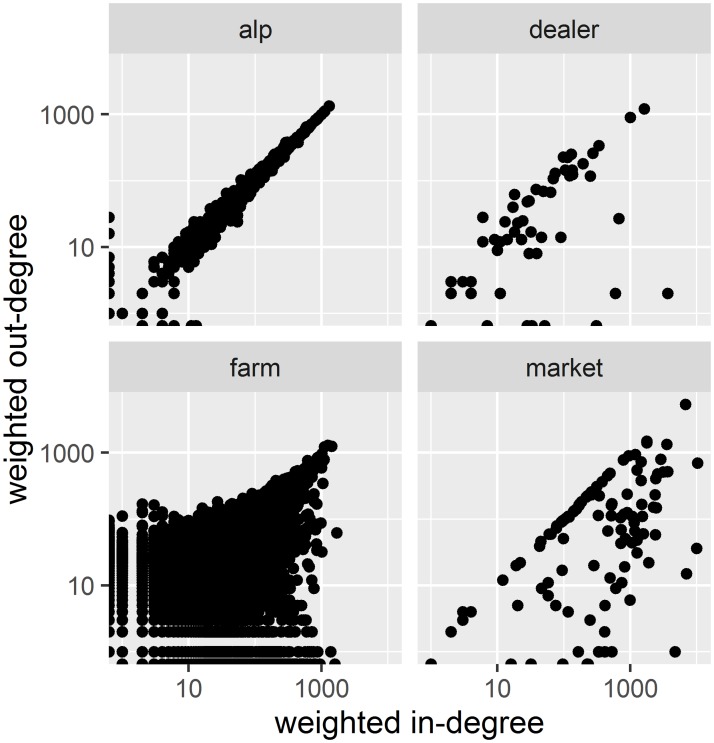
Scatter-plots of indegree versus outdegree (weighted data).Holding categories from left to right in alphabetical order: alp (holding at high altitude to access summer pasture), dealer, farm, market (including trade markets, auctions and exhibitions). Vertical axis: outgedree. Horizontal axis: indegree. Yearly weighted degrees are presented on a double logarithmic plot.